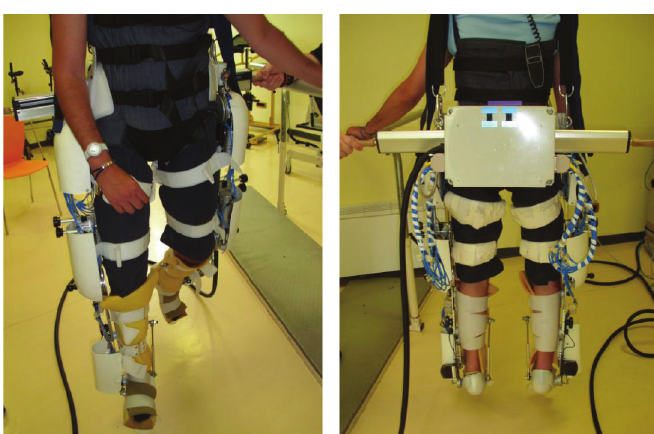
Figure 8: Motor training using